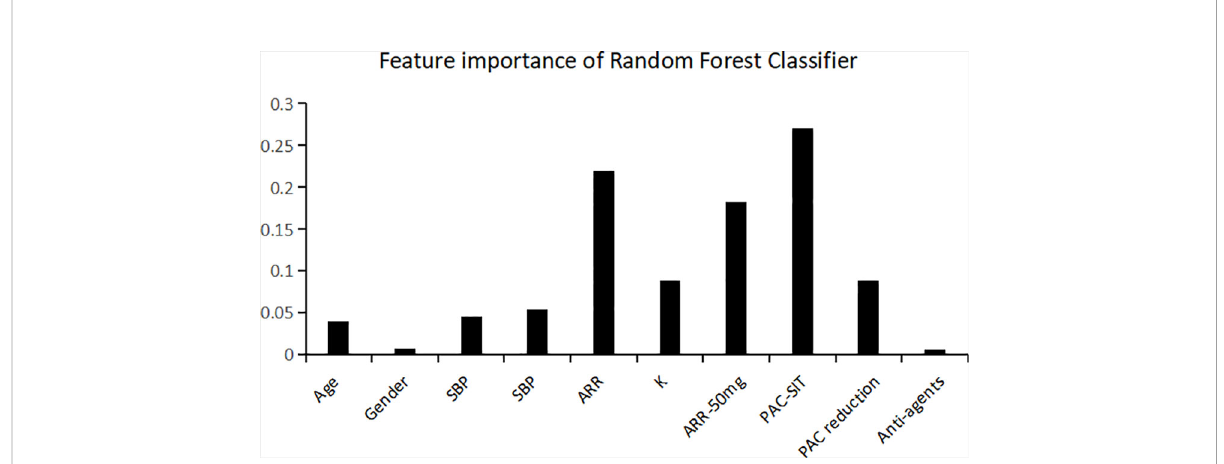
FIGURE 4 Relative variable importance for the accuracy of predicting unilateral primary aldosteronism using Random Forest classi fi er. SBP indicates systolic blood pressure; DBP, diastolic blood pressure; ARR, aldosterone to renin ratio; K, serum potassium level; PAC, plasma aldosterone concentration; SIT, saline infusion test; Anti-agents, the number of antihypertensive agents at